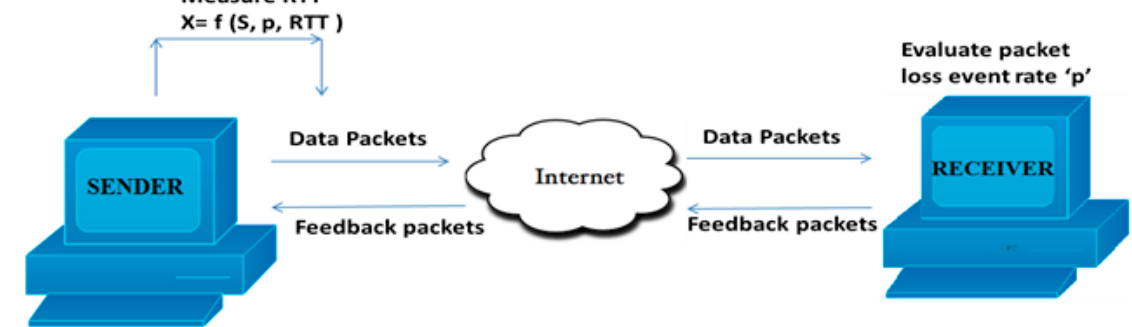
Figure 1. Functionality of TCP Friendly Rate Control mechanism.